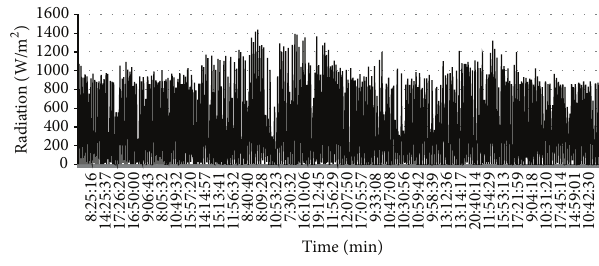
Figure 2: Radiation profile for 12,190 samples of field data.